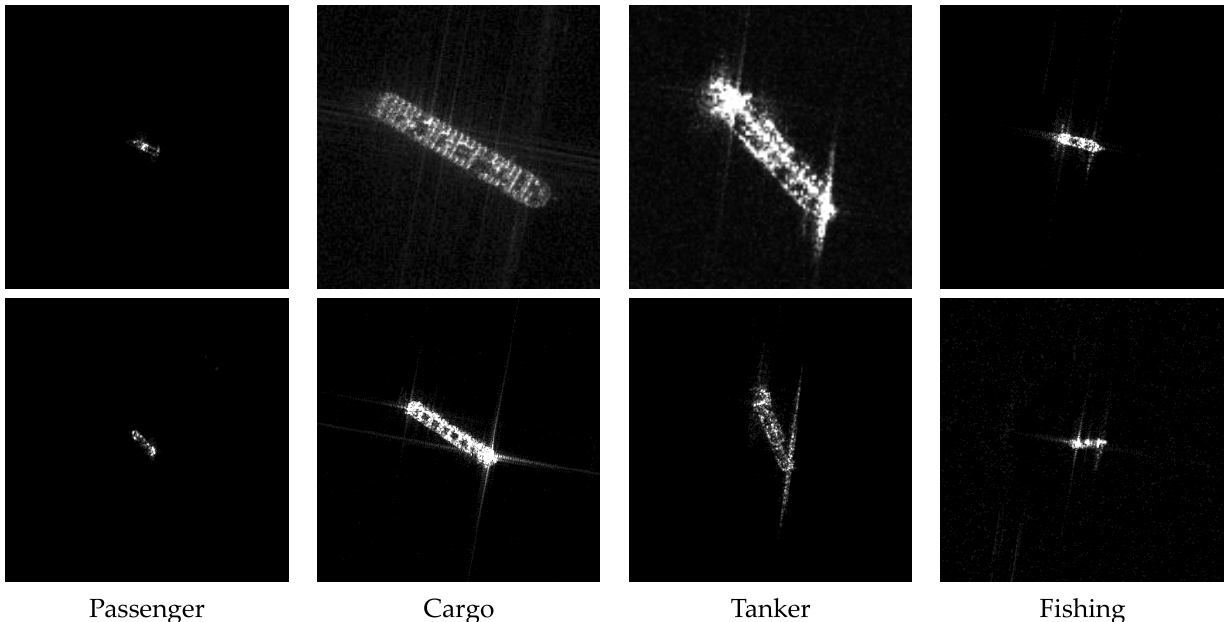
Figure 8. Samples of D SAR dataset.